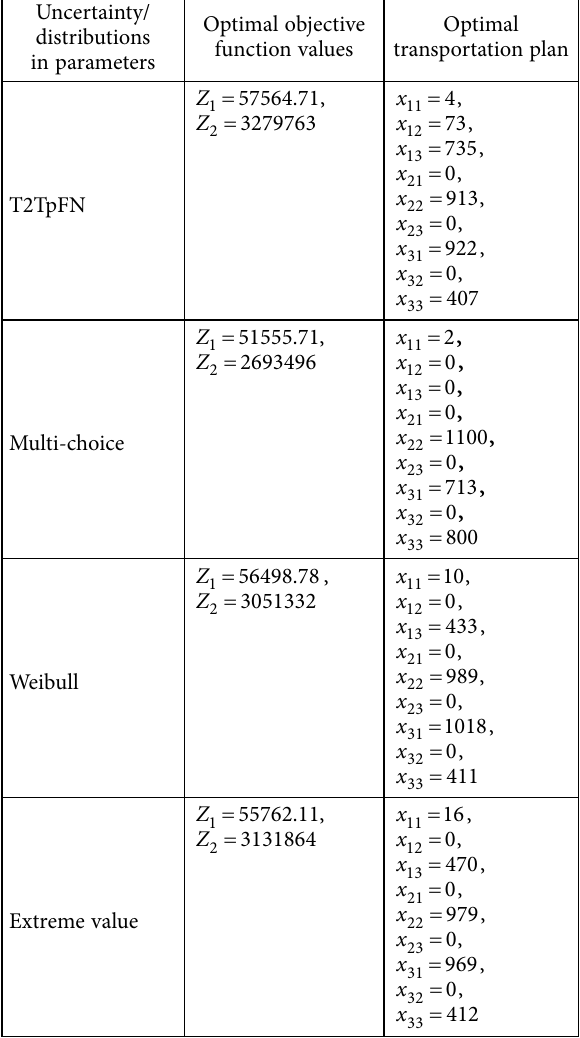
Optimal transportation